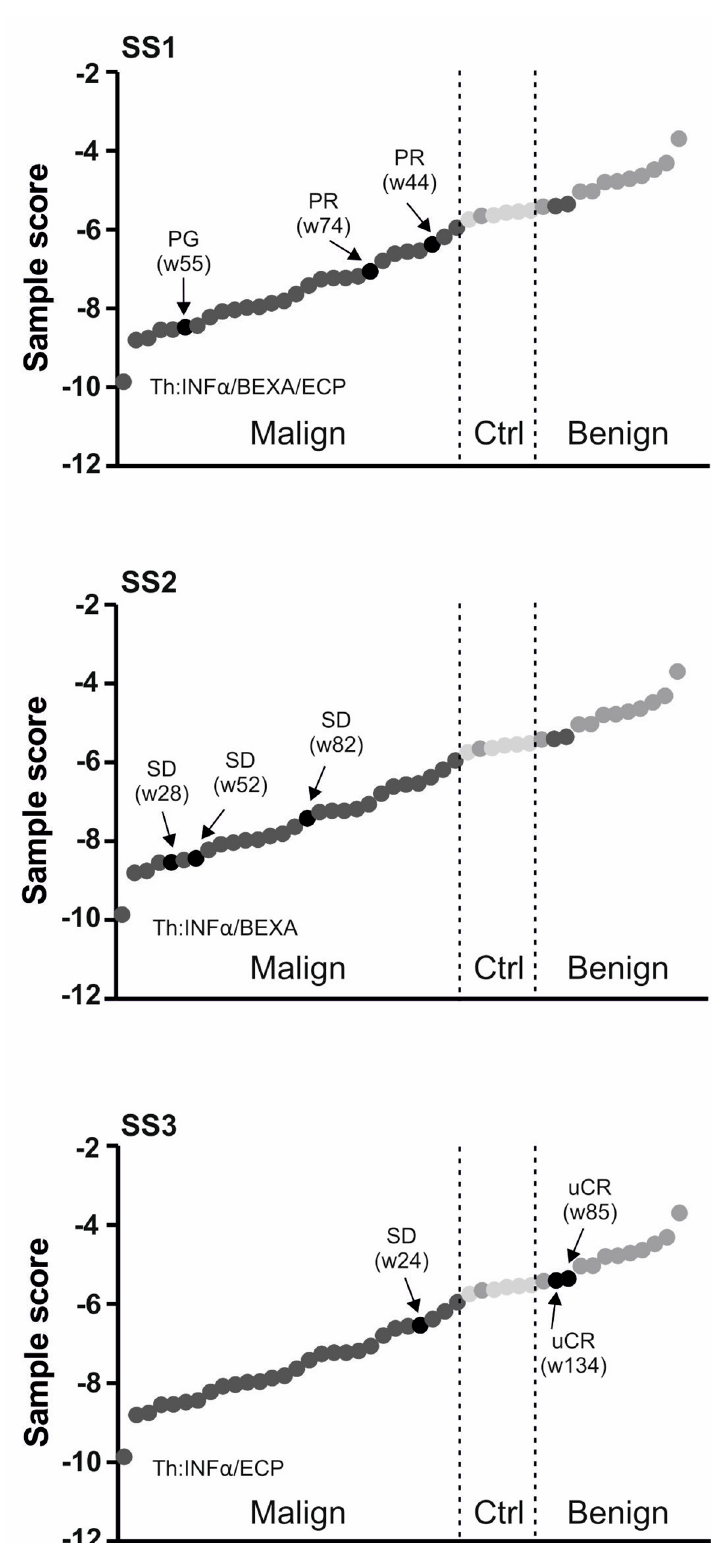
Figure 2. Plasma 3-miR-score in SS patients. Clinical data (SS1-3) are indicated including the therapy (Th) & response (see Table 1). For each sample the time in weeks (w) is calculated from the diagnosis. Each sample represented by a circle: empty healthy, grey BL, dark CTCL. Dashed lines separate diagnostic subgroups. Arrows indicate consecutive samples of a patient whose ID is placed on top.